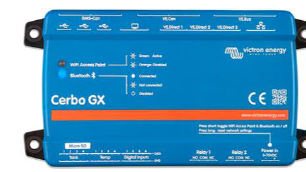
Figure 6. Cerbo GX